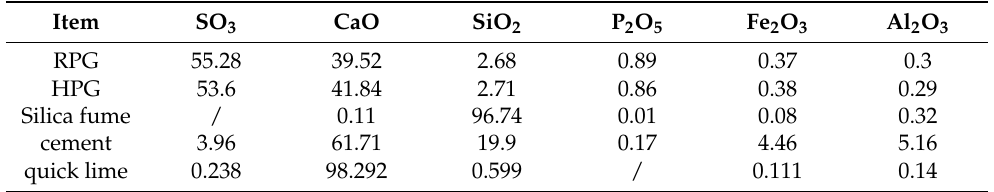
Table 1. Main chemical compositions of raw materials (wt/%).